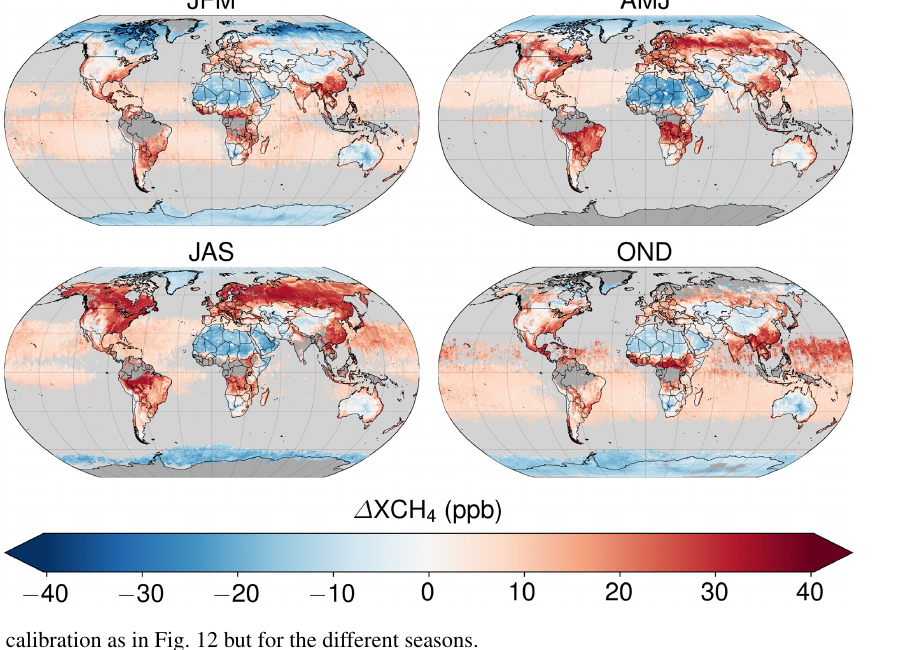
Figure 13. The global calibration as in Fig. 12 but for the different seasons.